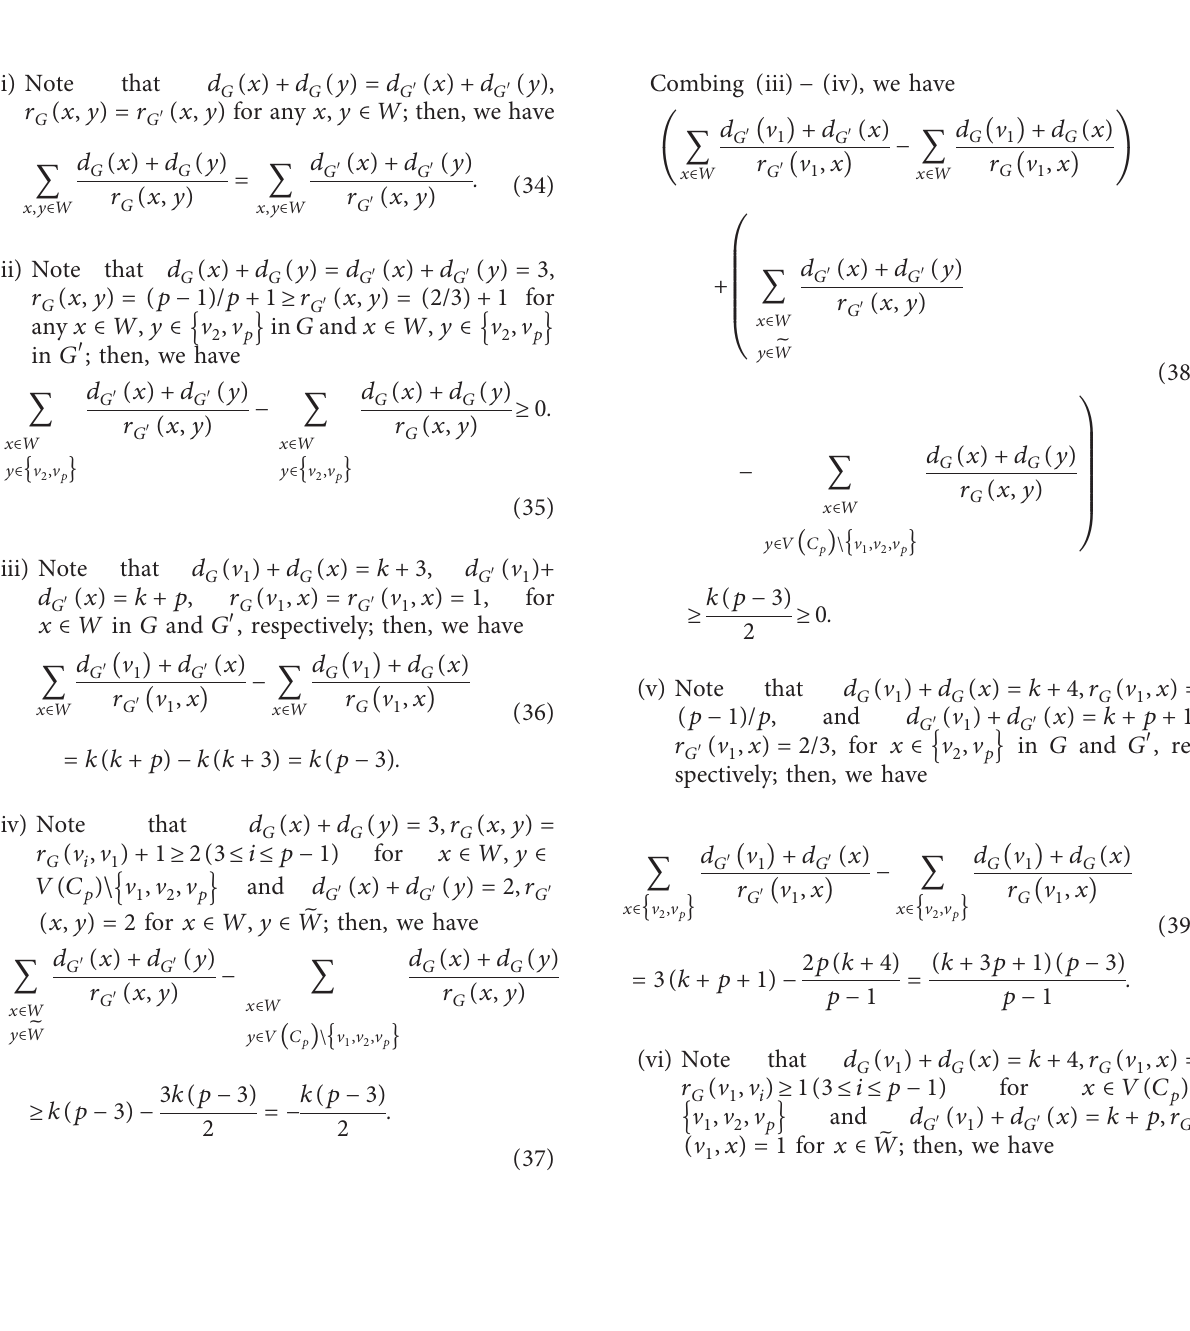
Figure 3: The cycle-shrinking transformation. (a) G . (b) G ′